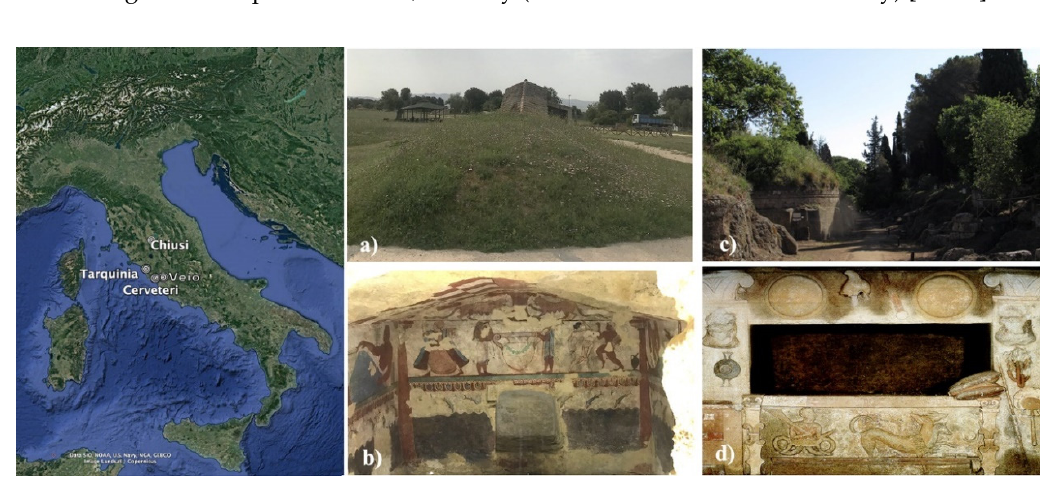
Figure 1. Location of the Italian study cases and details of two tombs belonging to the UNESCO World Heritage sites of the Necropolis of Tarquinia (Monterozzi) ( a ) external view, ( b ) mural paintings, and of Cerveteri (Banditaccia): ( c ) external view, ( d ) mural paintings. ( b , d : Courtesy of Amici delle Tombe di Tarquinia).